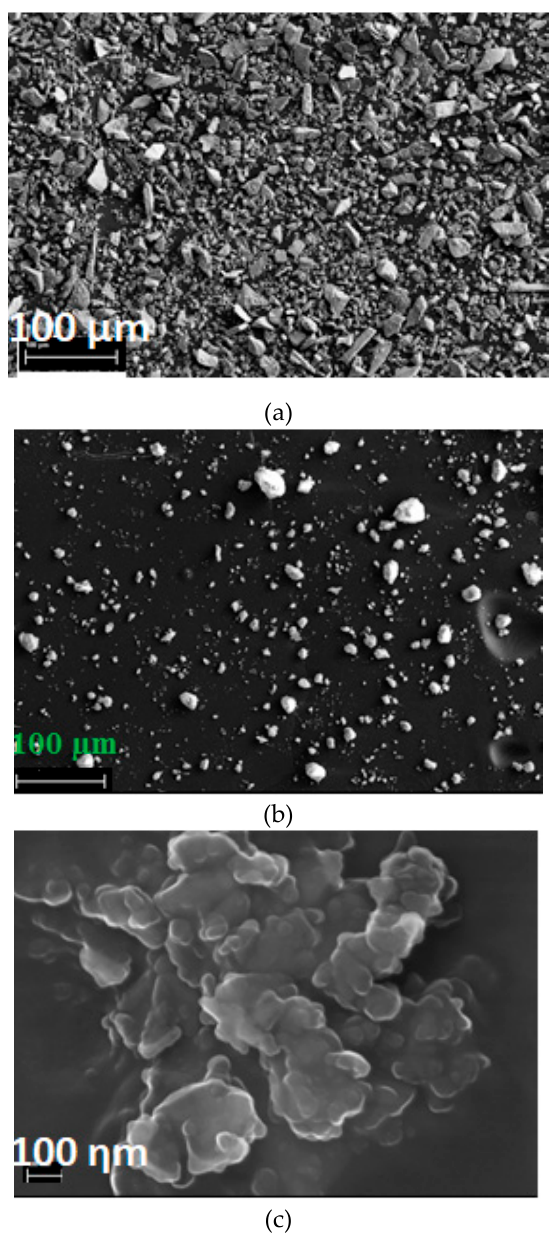
Figure 13. SEM micrograph for sub-20 micron olivine feed and concurrent ground products: ( a ) sub-20 micron olivine feed, ( b ) concurrent ground product, and ( c ) concurrent ground product nanometer-sized particles.